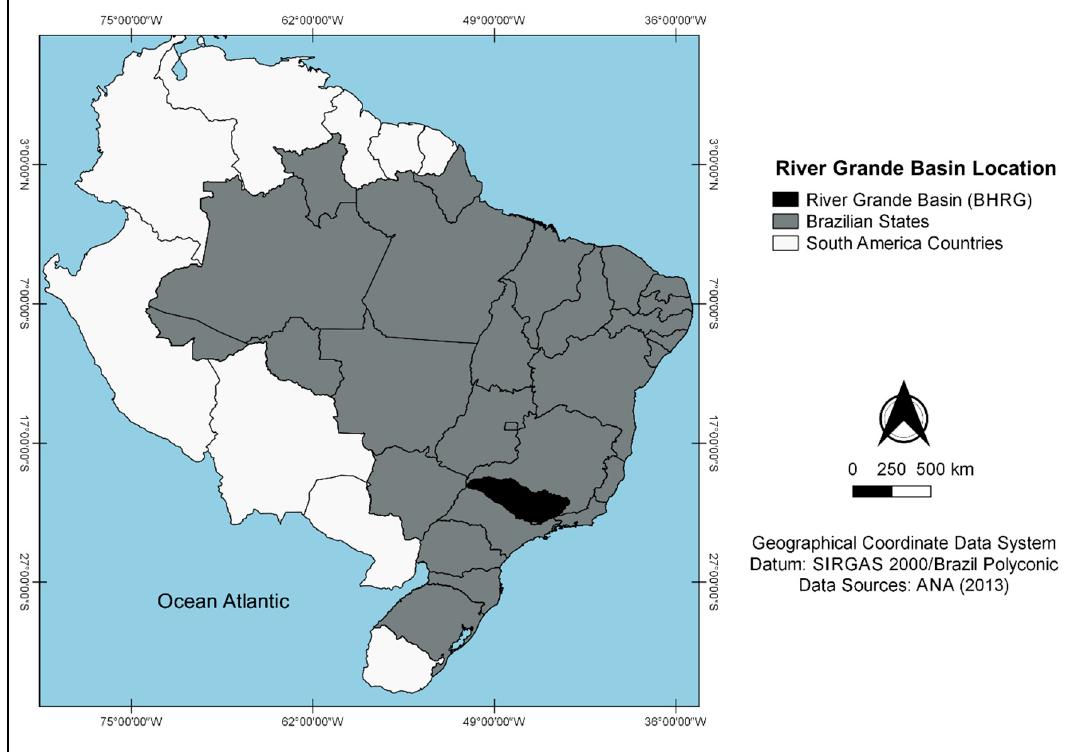
Figure 1. River Grande Basin Location.